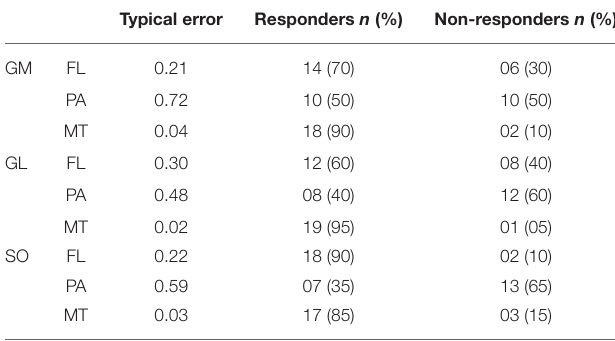
TABLE 2 | Individual responsiveness to eccentric training. Typical